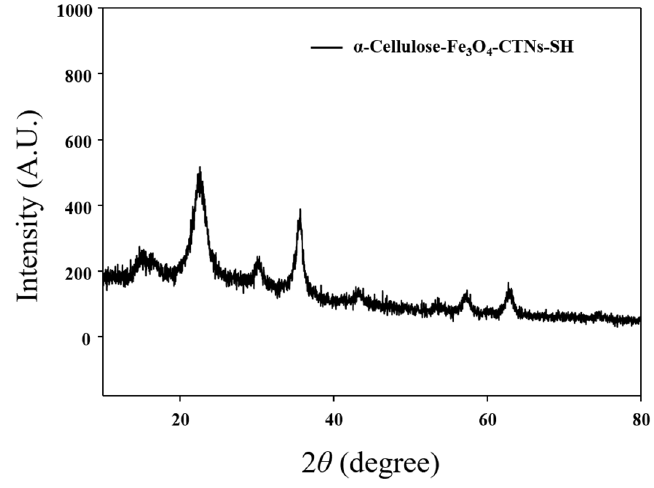
Figure 3. XRD analysis of the α -Cellulose-Fe 3 O 4 -CTNs-SH.